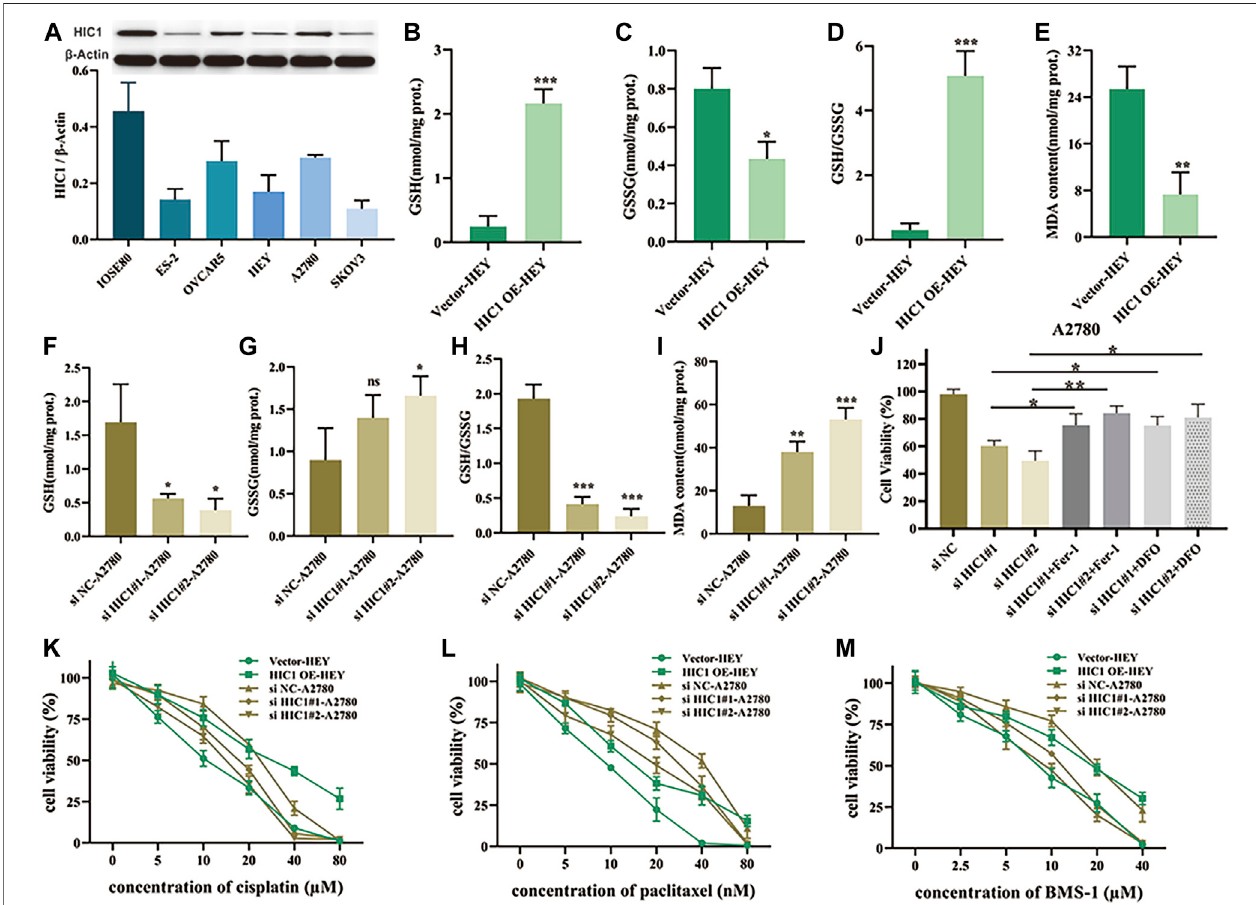
FIGURE7| InhibitionofHIC1improveddrugsensitivity ofchemotherapy andanti-PD1therapy via inducingferroptosisinovariancancercells. (A) HIC1expression in fi ve ovarian cancer cell lines (ES-2, OVCAR5, HEY, A2780, and SKOV3) and the human normal ovarian epithelial cell line IOSE80 was detected by Western Blotting. A2780 cells were transfected with negative control siRNA or HIC1 siRNA and then GSH content, GSSG content, the ratio of GSH/GSSG (B – D) and MDA content (E) were assessed. HEY cells were transfected with empty vector or HIC1 expression plasmid, then GSH content, GSSG content, the ratio of GSH/GSSG (F – H) and MDA content (I) were detected. (J) A2780 cells were treated 2 μ M Fer-1 or 20 μ M DFO for 24 h after transfected with negative control siRNA or HIC1 siRNAs, then cell viabilitywasevaluatedbyCCK8assays.Cellviabilitywasevaluated byCCK8 assaysinA2780 cellswithorwithoutHIC1 knockdown andHEYcells withorwithoutHIC1 overexpression after treatment with different concentration of cisplatin (K) , paclitaxel (L) , or BMS-1 (M) for 24 h, respectively.